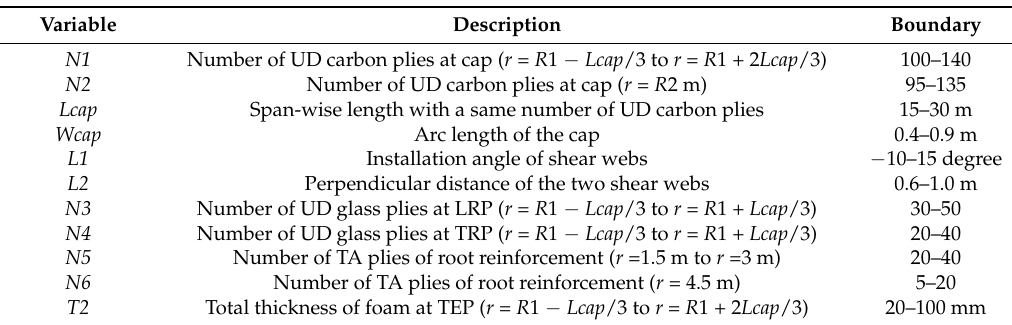
Table 1. Description of design variables.